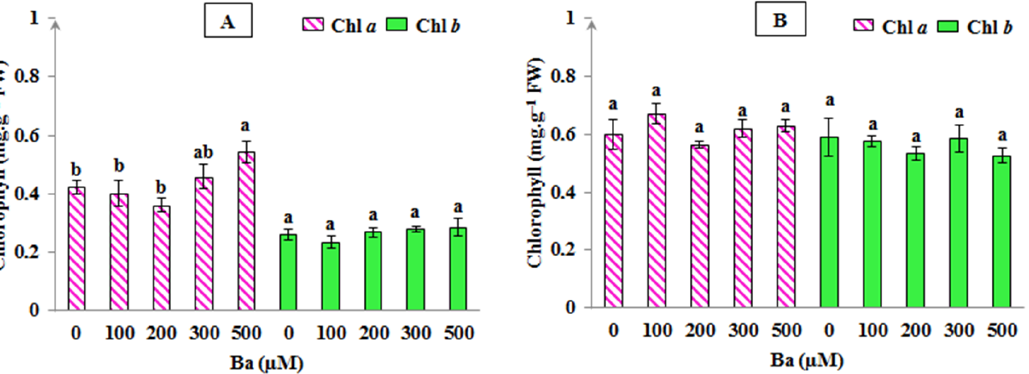
Figure 3. Chlorophyll a and b levels in Limbarda crithmoides ( A ) and Helianthus annuus ( B ) leaves after 45 days of Ba exposure. Data are presented in mean values ± SD, n = 10. Bars marked with lower-case letters were significantly different at p < 0.05.